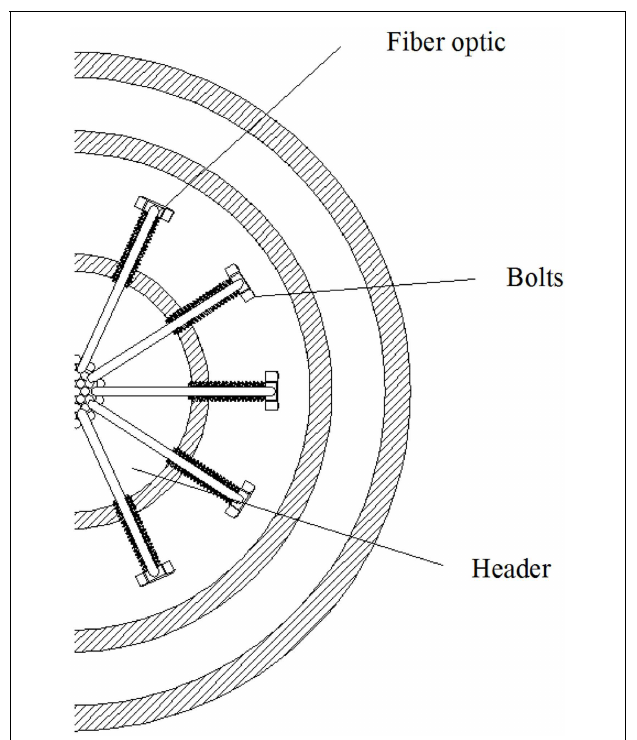
FIGURE 2 | Cross section of the air-lift photobioreactor